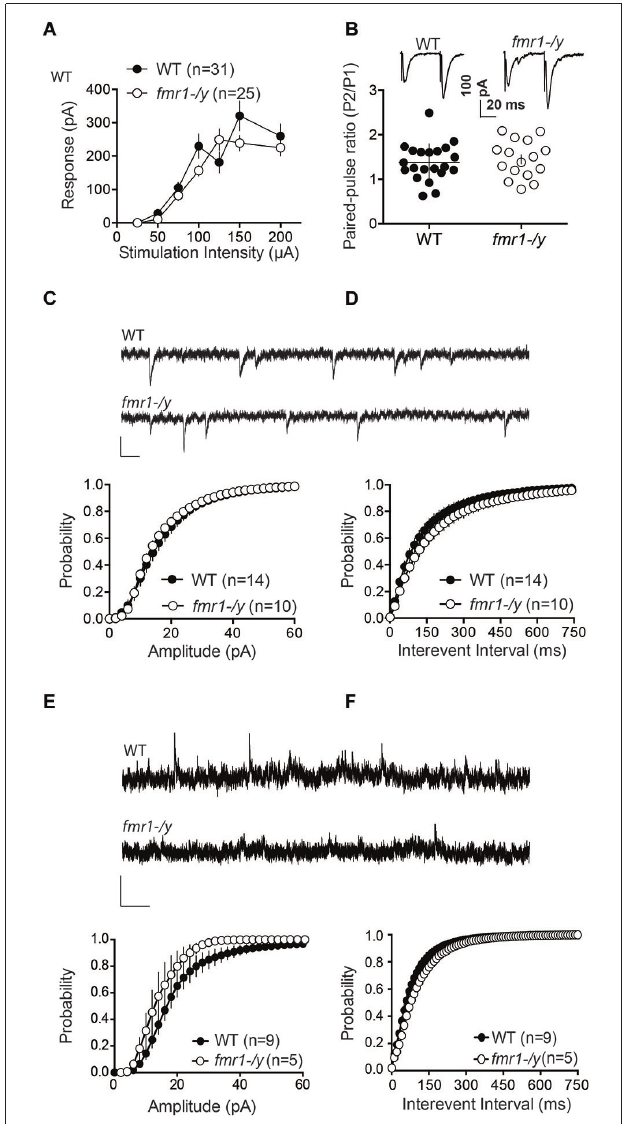
FIGURE 4 | Glutamatergic transmission parameters in the nucleus accumbens of wild-type and fmr-/y mice. (A) Average field responses to electric stimulation of increasing intensity did not reveal a significant difference in synaptic excitability between the two genotypes. The overall excitability was not significantly different between the two genotypes ( p = 0.1436, 2-way ANOVA, the number of animals tested differed between stimulation intensities n = 14--31, data not shown). (B) Example traces illustration the response to paired stimulations for a wild type (upper trace) and a fmr1-/y mouse (lower trace). The comparison of the median paired-pulse ratios for a stimulus interval of 50ms revealed no significant difference between the two genotypes ( p = 0.4354, WT n = 21, fmr1-/y n = 16, students t -test). (C) Sample traces from accumbens MSN clamped at − 70 mV from wild type and fmr1/y animals (scale bar: 50 ms, 20 pA). The cumulative probability distribution of AMPAR sEPSCs amplitudes revealed no differences between the two genotypes (Kolmogorov-Smirnov-test; WT n = 14, black symbols; fmr1-/y n = 10, white symbols). (D) The cumulative probability distribution of AMPAR sEPSCs inter-event-intervals revealed no differences in spontaneous synaptic transmission between the two genotypes (Kolmogorov-Smirnov-test; WT n = 14, black circles; fmr1-/y n = 10, white circles). (E) Sample traces from ( Continued )